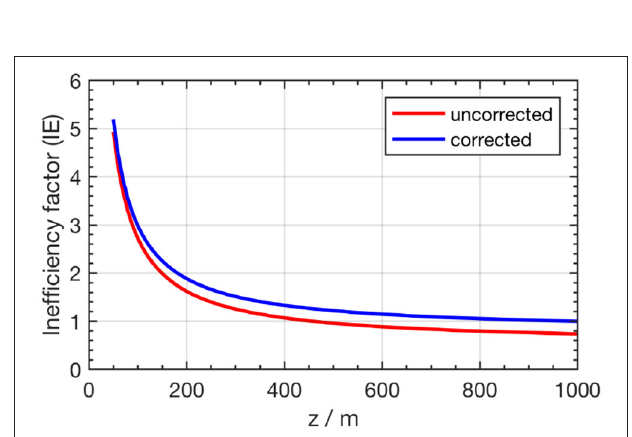
FIGURE 4 | Inefficiency curve before ( IE ( z ): red) and after the correction ( IE ′ ( z ):